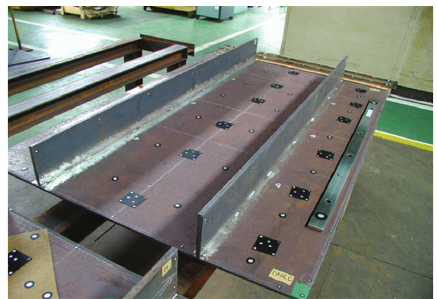
Figure 8: Experimental model of panel